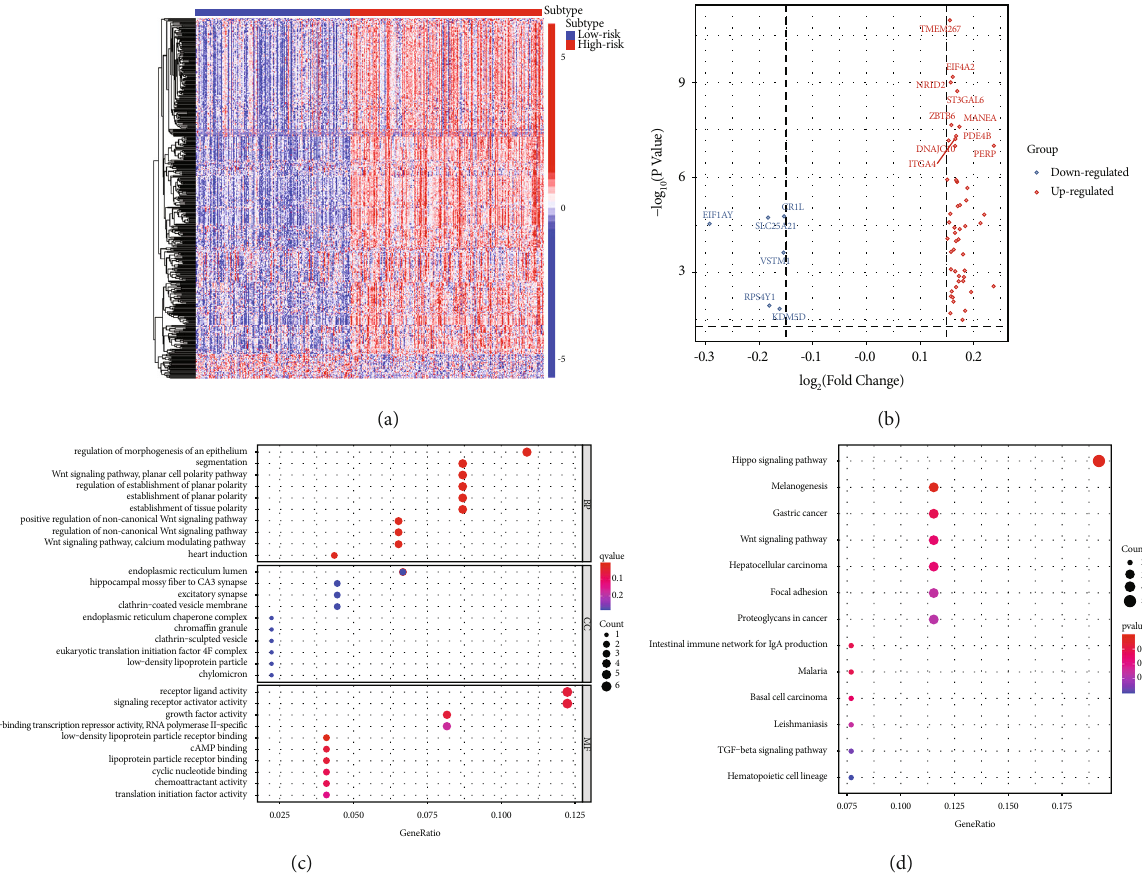
Figure 5: Identi fi cation and enrichment of di ff erentially expressed genes (DEGs). (a) DEGs are represented as a heat map. (b) ARGs with signi fi cant di ff erential expression. (c) DEGs were subjected to a GO functional enrichment analysis. (d) DEGs were subjected to KEGG pathway